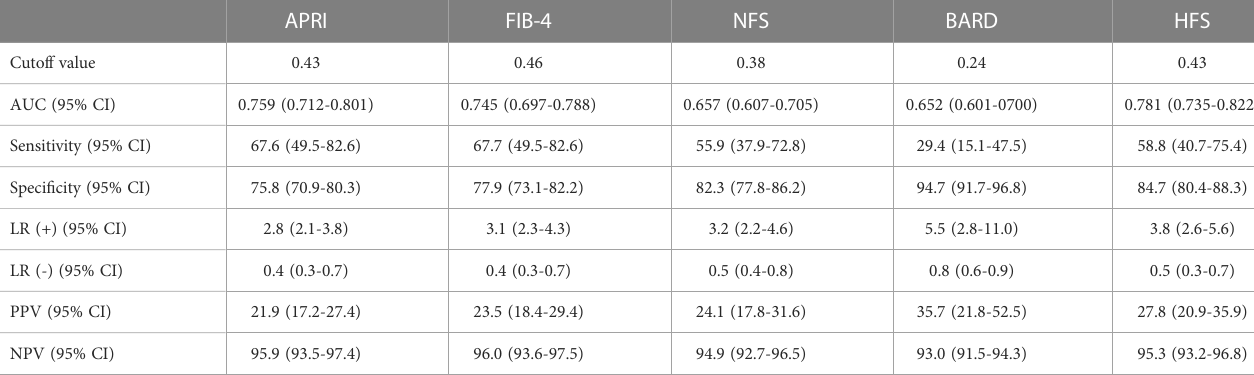
TABLE 4 Performance of the APRI, FIB-4, NFS, BARD and HFS for the detection of signi fi cant fi